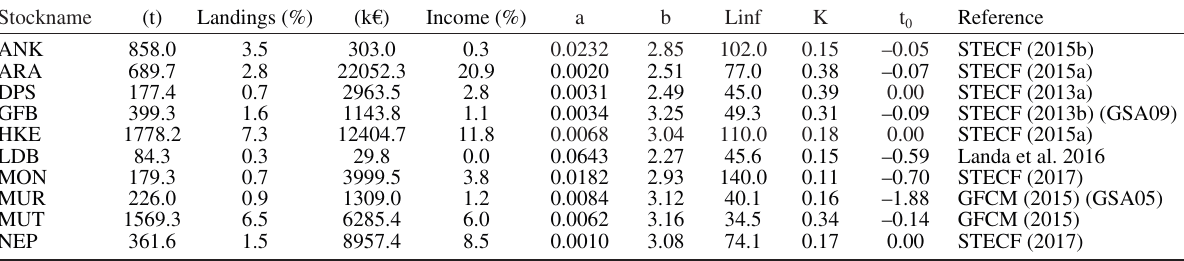
Table 1. – Selected species: landings and income in GSA 6 in 2015 (DCF) and length-weight relationship and growth parameters (VBGC) used to run MEFISTO, taken from referenced assessments. Lepidorhombus boscii (LDB) had not been assessed previously (ANK, Lophius budegassa ; ARA, Aristeus antennatus ; DPS, Parapenaeus longirostris ; GFB, Phycis blennoides ; HKE, Merluccius merluccius ; LDB, Lepi- dorhombus boscii ; MON, Lophius piscatorius ; MUR, Mullus surmuletus ; MUT, Mullus barbatus ; NEP, Nephrops novegicus ).